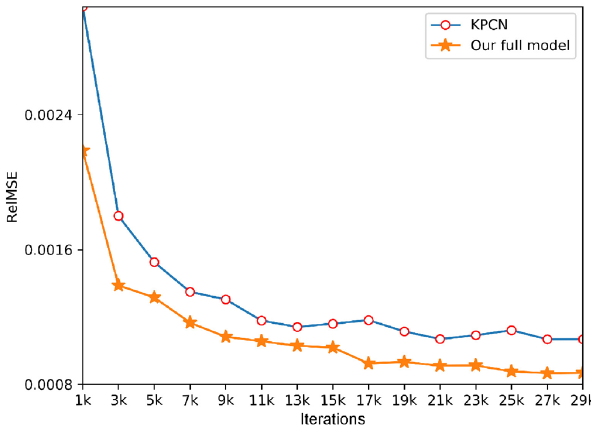
Fig. 8 RelMSE as a function of training iterations for our method and KPCN. Our method is consistently better than